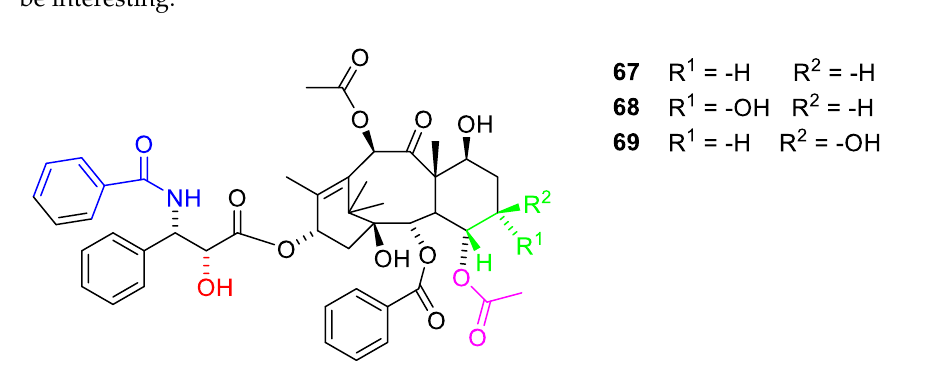
Figure 19. Paclitaxel analogues with no oxetane ring [70].